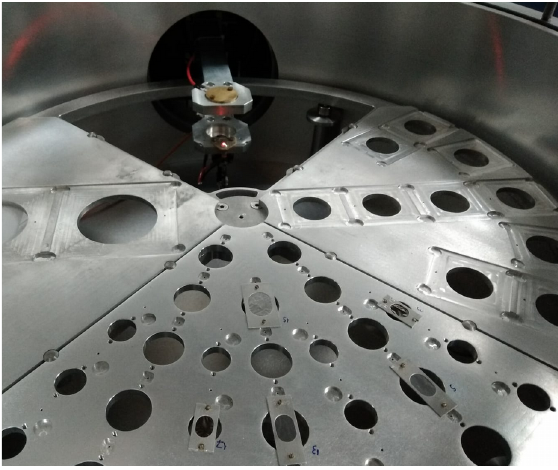
Fig. 3. Alpha-particle transmission setup at INFN-LNS